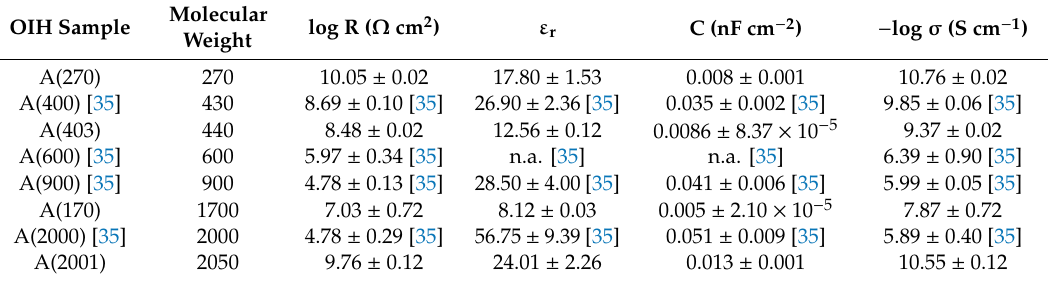
Table 2. Electrical properties of the OIH samples based on A(X) matrices. For comparison purposes the data reported for A(400) [35], A(600) [35], A(900) [35], and A(2000) [35] were also